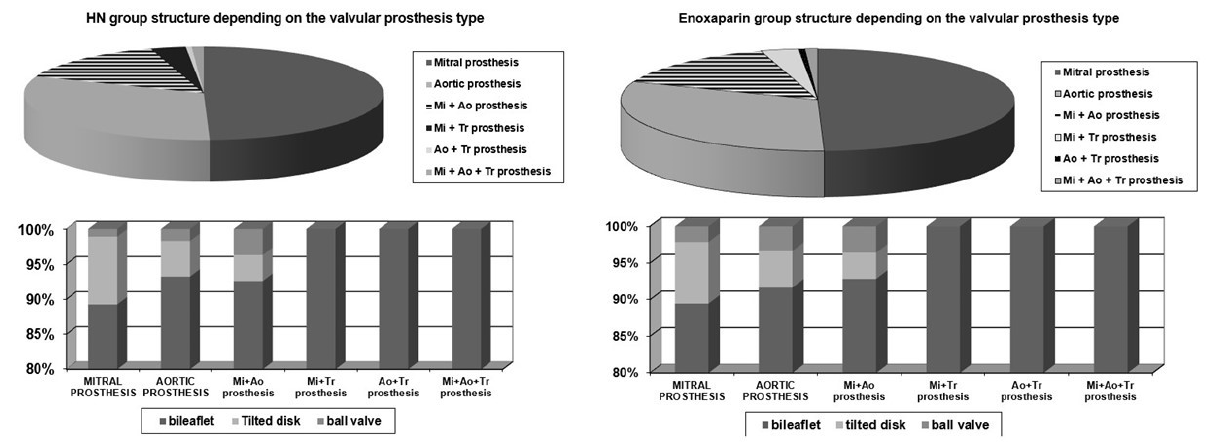
Figure 2. Valvular prosthesis type in the study groups. There were no significant differences between the study groups concerning in-hospital concomitant medications (Table 3). The proportion of patients receiving antiplatelet therapy with Aspirin, Ticlopidine, or Clopidogrel was 7.81% in group A and 7.45% in group B. Table 3. Concomitant cardiovascular medications during hospital stay in study groups (number of patients/percent).